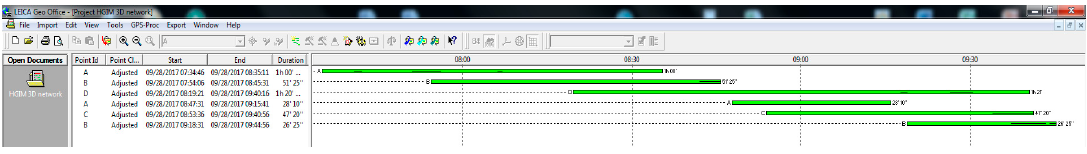
Figure 4. GNSS observations sessions.